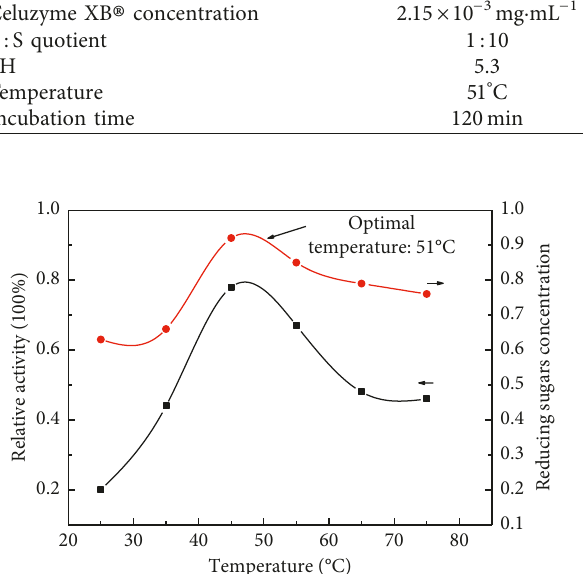
Figure 1: Enzyme complex activity as a function of